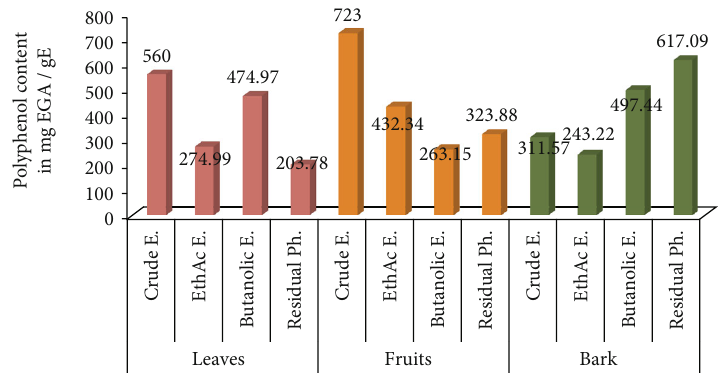
Figure 2: Polyphenol content in mg EGA/gE of Pistacia atlantica Desf. extracts.